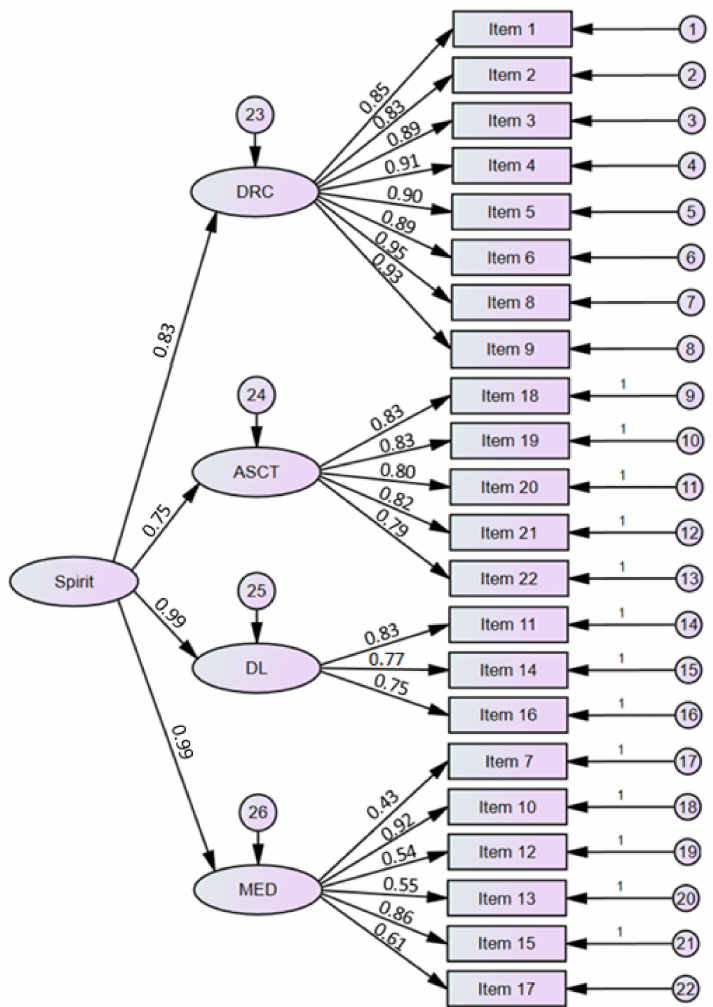
Figure 1. Structure of the Polish version of the Interfaith Spirituality Scale (DRC = direct connection with the creator, ASCT = asceticism, DL = divine love, and MED =